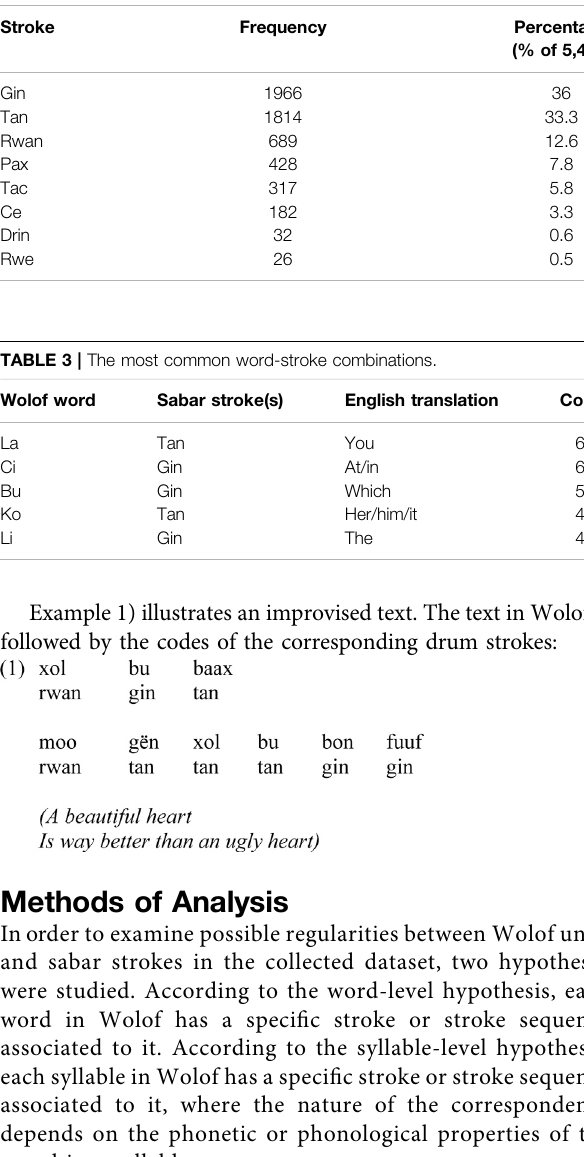
TABLE 2 | Frequencies of strokes.